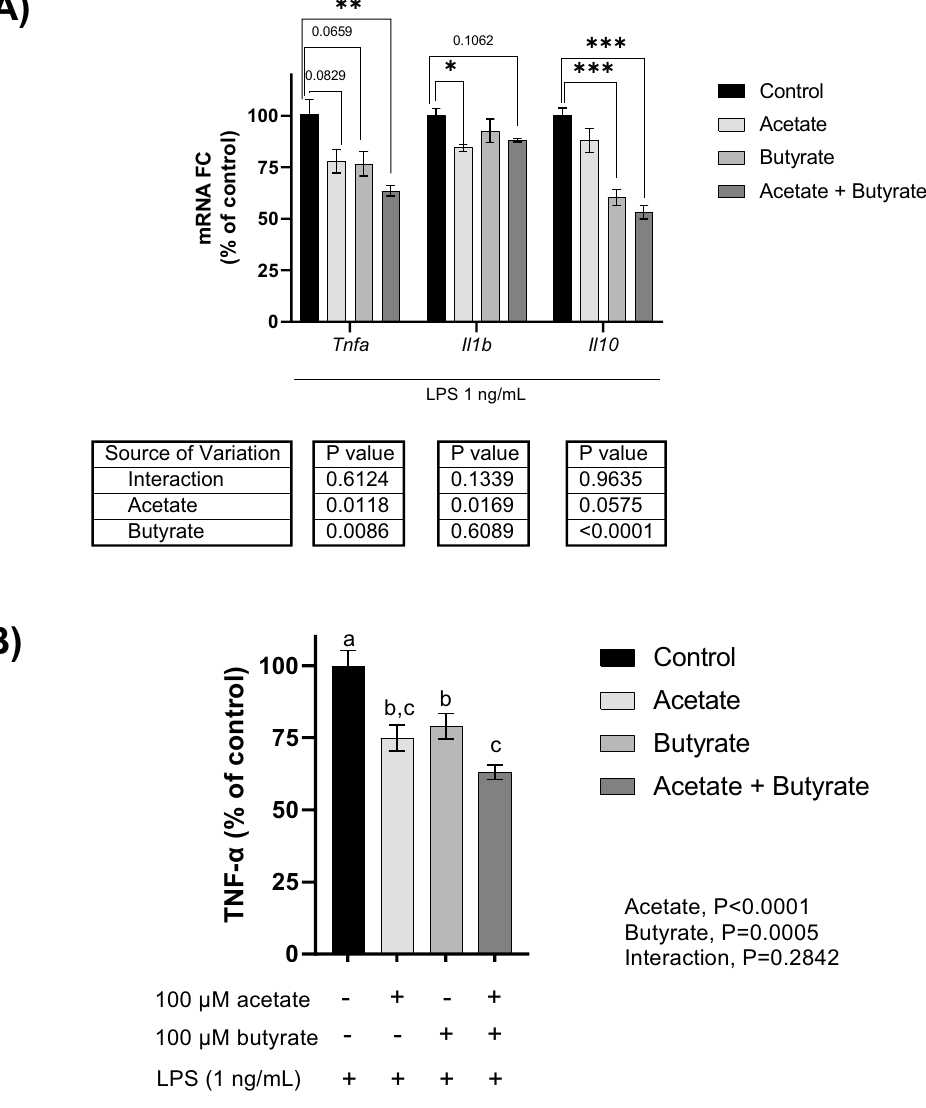
Figure 3. Effect of short-chain fatty acids on ( A ) cytokine mRNA expression (measured by qPCR) and ( B ) TNF-α protein secretion (measured by ELISA) after LPS stimulation of primary microglia. Cells were pre- treated with acetate, butyrate, or combination of both (0 or 100 µM) for 4 h, and then stimulated with LPS (1 ng/mL) for 4 h. Control = cells stimulated with LPS and no pre-treatment with SCFA. Samples were analyzed by 2-way ANOVA (2 × 2 factorial arrangement of acetate x butyrate), followed by ( A ) Dunnet’s test (* P < 0.05, ** P < 0.01, *** P < 0.001, and **** P < 0.0001) or ( B ) Tukey’s test. Different lowercase letters are statistically different ( P < 0.05) among